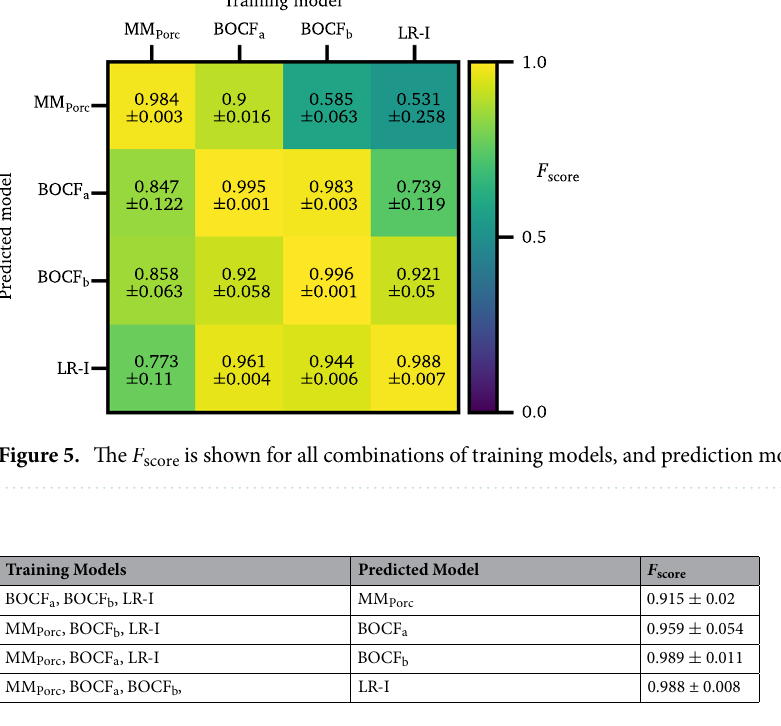
Table 2. This table lists the F score values for the case, where the UNet was trained with three cell models, and the prediction was performed on the fourth remaining (unknown) cell